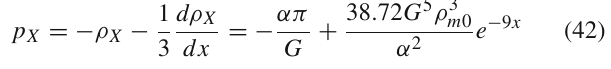
The corresponding equation of state of dark energy ω X =